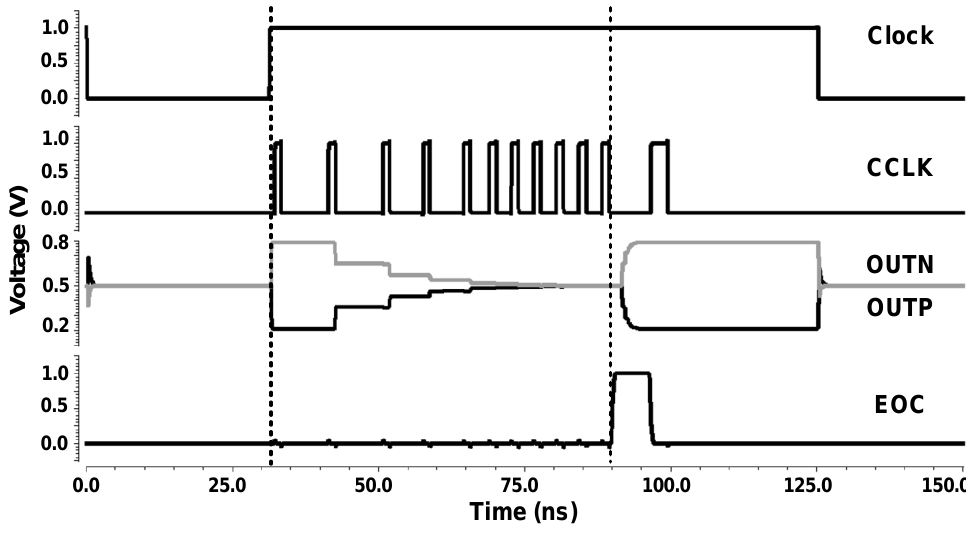
Figure 9. Capacitive DAC simulation result.